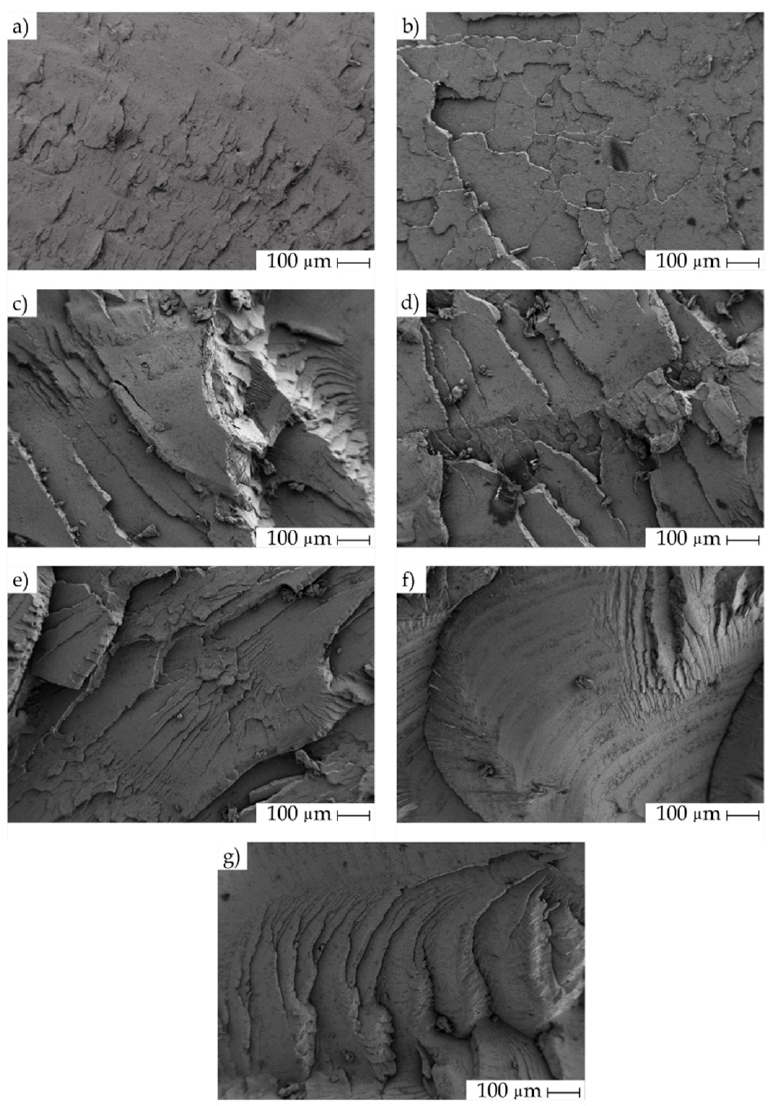
Figure 1. Field emission scanning electron microscopy (FESEM) images of the fracture surfaces of the injection-molded polylactide (PLA) pieces subjected to di ff erent reprocessing cycles: ( a ) PLA0, ( b ) PLA1, ( c ) PLA2, ( d ) PLA3, ( e ) PLA4, ( f ) PLA5, and ( g ) PLA6. Images were taken at 1000 × and scale markers are of 100 µm.